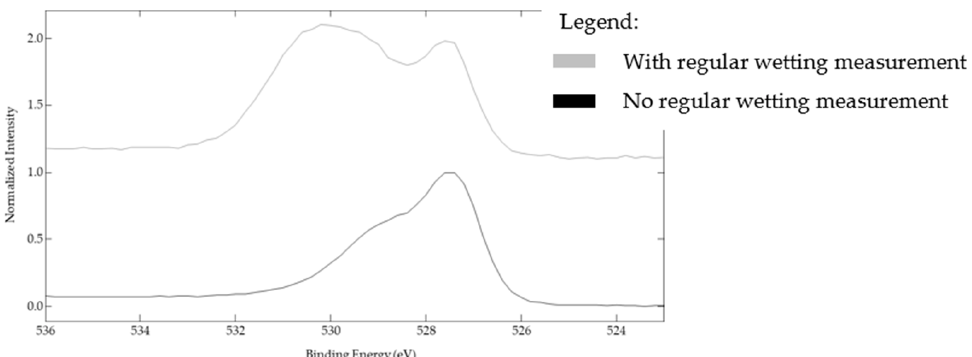
Figure 16. O1s spectra of the samples with no square pillars’ top irradiation textured under a CO 2 flow and for which wetting evolution measurements were carried out (top spectrum—gray line) or were not carried out (bottom spectrum—black line).